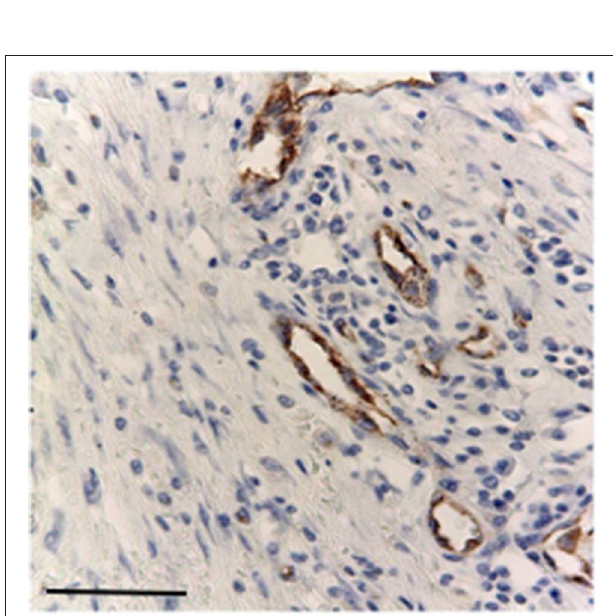
FIGURE 6 | Immunostaining primary antibodies for CD31 in endothelial cells stroma, Bar 100 µ m.